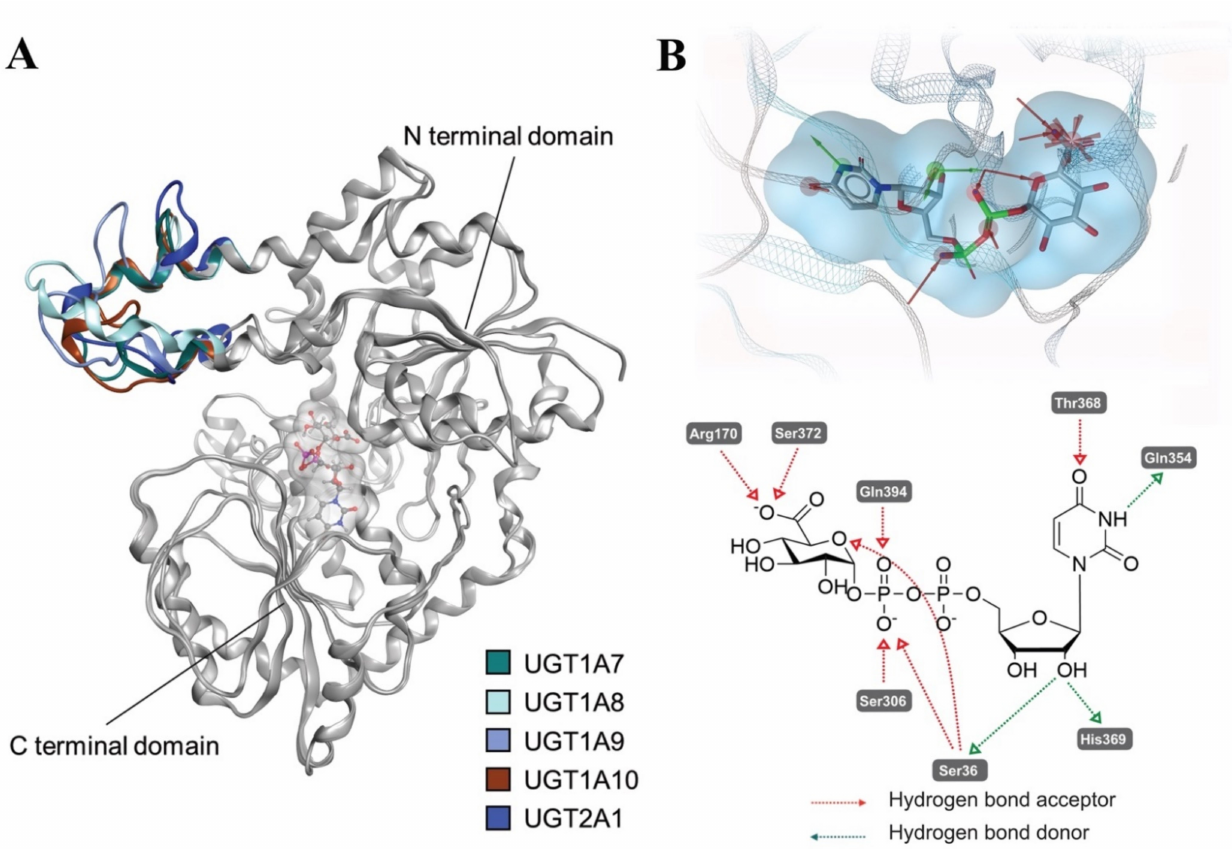
Figure 6. Comparison of the UGT1A7, UGT1A8, UGT1A9, UGT1A10 and UGT2A1 homology models. ( A ) Alignment of UGT1A7, UGT1A8, UGT1A9, UGT1A10 and UGT2A1 homology models. The major body was colored gray, and the most various part was colored for comparison: UGT1A7 (dark green), UGT1A8 (light green), UGT1A9 (light blue), UGT1A10 (brown) and UGT2A1 (dark blue). ( B ) Binding mode of UDPGA at the UGT1A7 binding site. The ligand molecular surface is presented transparently blue. 3D pharmacophores were generated to show the interactions between UDPGA and UGT1A7: hydrogen bond donors (HBD, green arrows), hydrogen bond acceptors (HBA, red arrows) and negative charge (red star). A 2D schematic diagram is shown